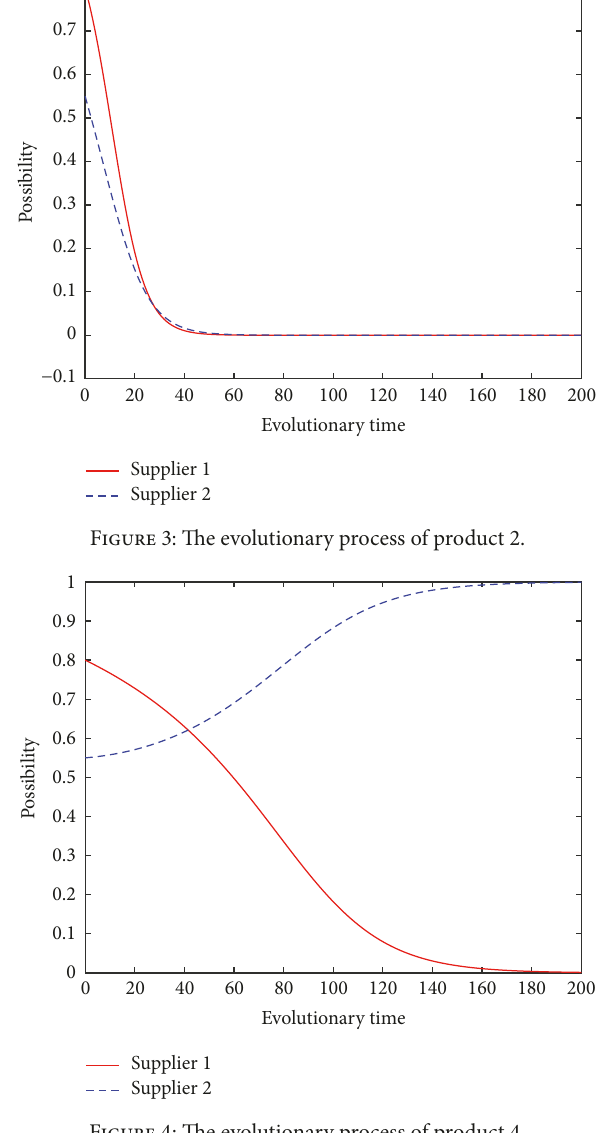
Figure 4: The evolutionary process of product